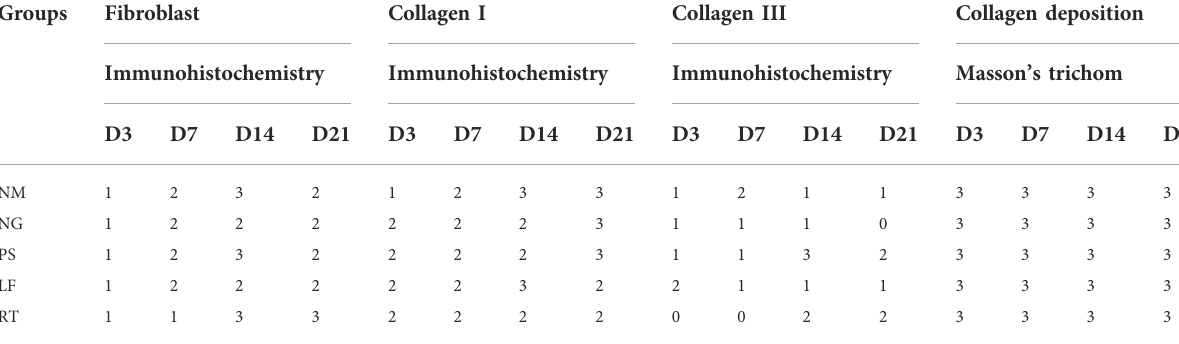
TABLE 5 Scoring for Masson ’ s trichome staining (collagen deposition) and immunohistochemistry staining ( fi broblast, collagen I and III) of the burn wounds at Day 3, 7, 14, and 21.